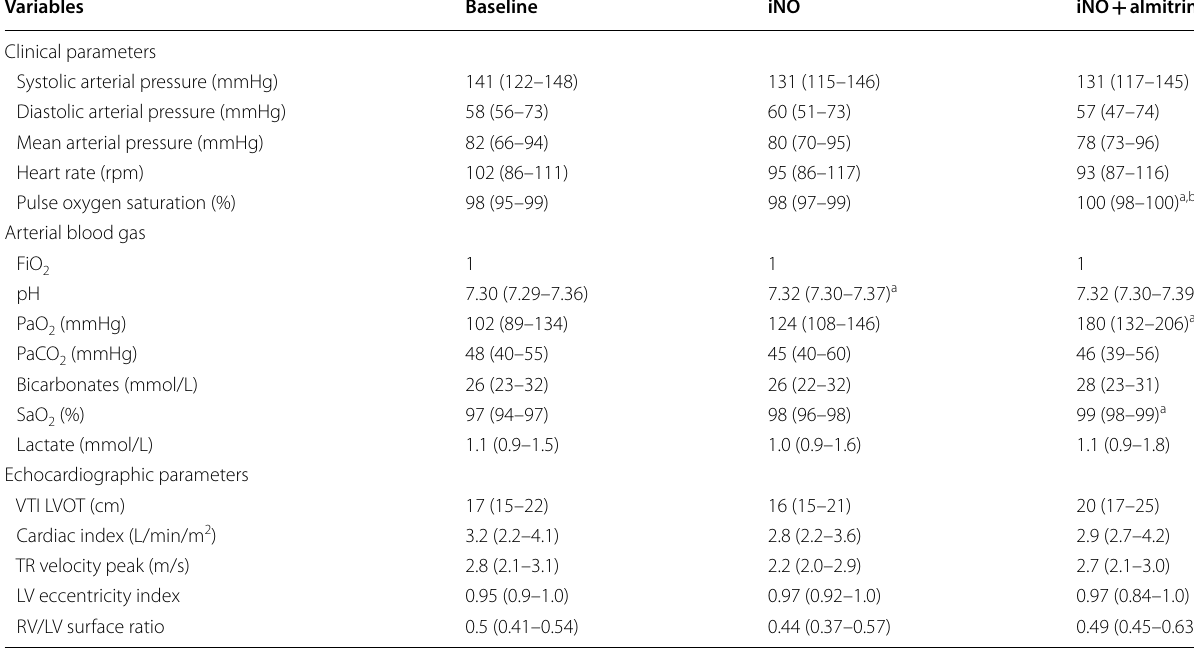
Values are expressed as median (interquartile range) iNO inhaled nitric oxide, FiO 2 fraction of inspired oxygen, PaO 2 arterial oxygen tension, PaCO 2 arterial carbon dioxide tension, SaO 2 arterial oxygen saturation, VTI LVOT velocity–time integral of left ventricular outflow tract, TR tricuspid regurgitation, LV left ventricle, RV right ventricle a Denotes a p value < 0.05 as compared to baseline, for paired Wilcoxon (with Benjamini–Hochberg correction) following Friedman test b Denotes a p value < 0.05 as compared to iNO, for paired Wilcoxon (with Benjamini–Hochberg correction) following Friedman test. Baseline denotes supine position, a median of 4 [2–6] hours after end of last proning session